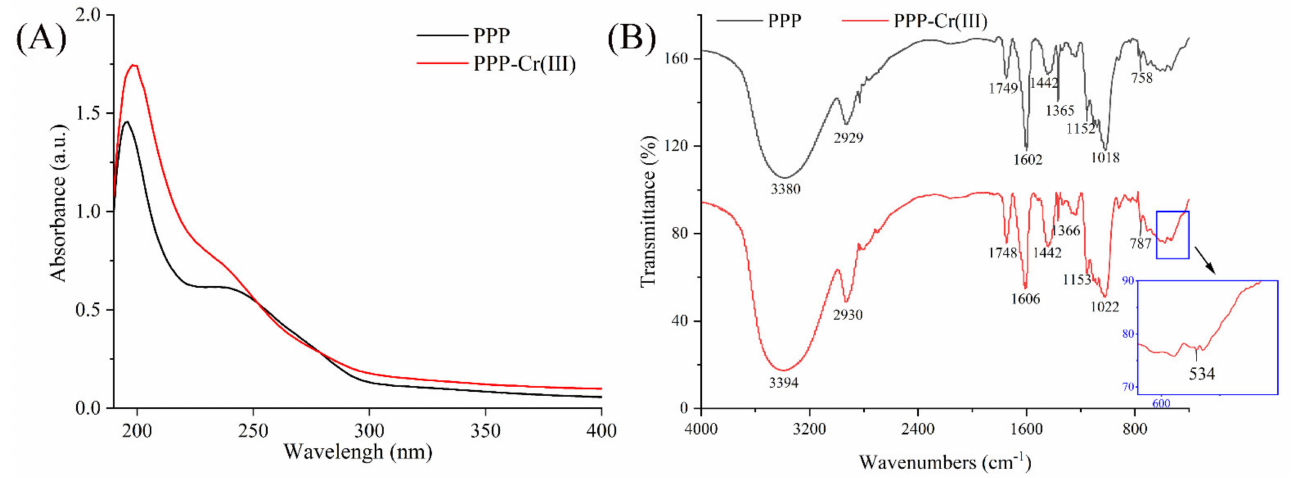
Figure 1. UV-vis ( A ) and FT-IR ( B ) spectra of PPP and PPP-Cr(III). The FT-IR spectra of PPP and PPP-Cr(III) are shown in Figure 1B. The strong peaks at 3380 cm − 1 and 2929 cm − 1 are attributed to O-H bond stretching vibration and C-H bond stretching vibration of the -CH 2 groups, respectively [18]. The peaks at 1749 cm − 1 were attributed to C=O stretching vibration, indicating the presence of uronic acid in PPP. The absorptions at 1606 cm − 1 and 1442 cm − 1 were anti-symmetrical C=O stretching vibration and symmetrical C=O stretching vibration of ionic carboxyl groups (i.e., − COOH − ) [37]. Overall, the FT-IR spectra of PPP exhibited a typical polysaccharide structure. After the introduction of Cr(III), most of the characteristic peaks were similar to PPP, demonstrating that the main functional groups were not changed after complexation with Cr(III).